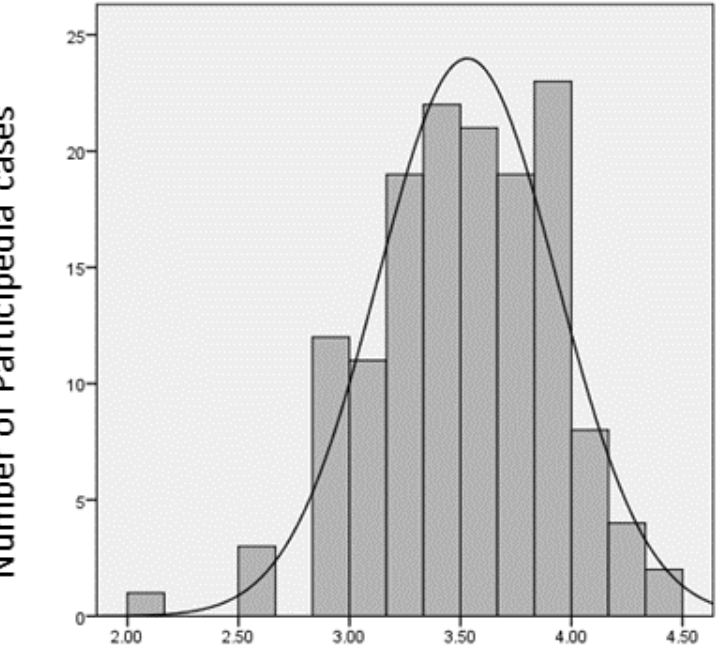
Figure 3. Frequency distribution of average scale rating across all scales. Note. N = 145. Average scale rating is the arithmetic mean of the 16 multi-item scales and the single-item scale ( Representative sample ) employed in the analysis. See Tables 1, 1A, and 2A, and text for